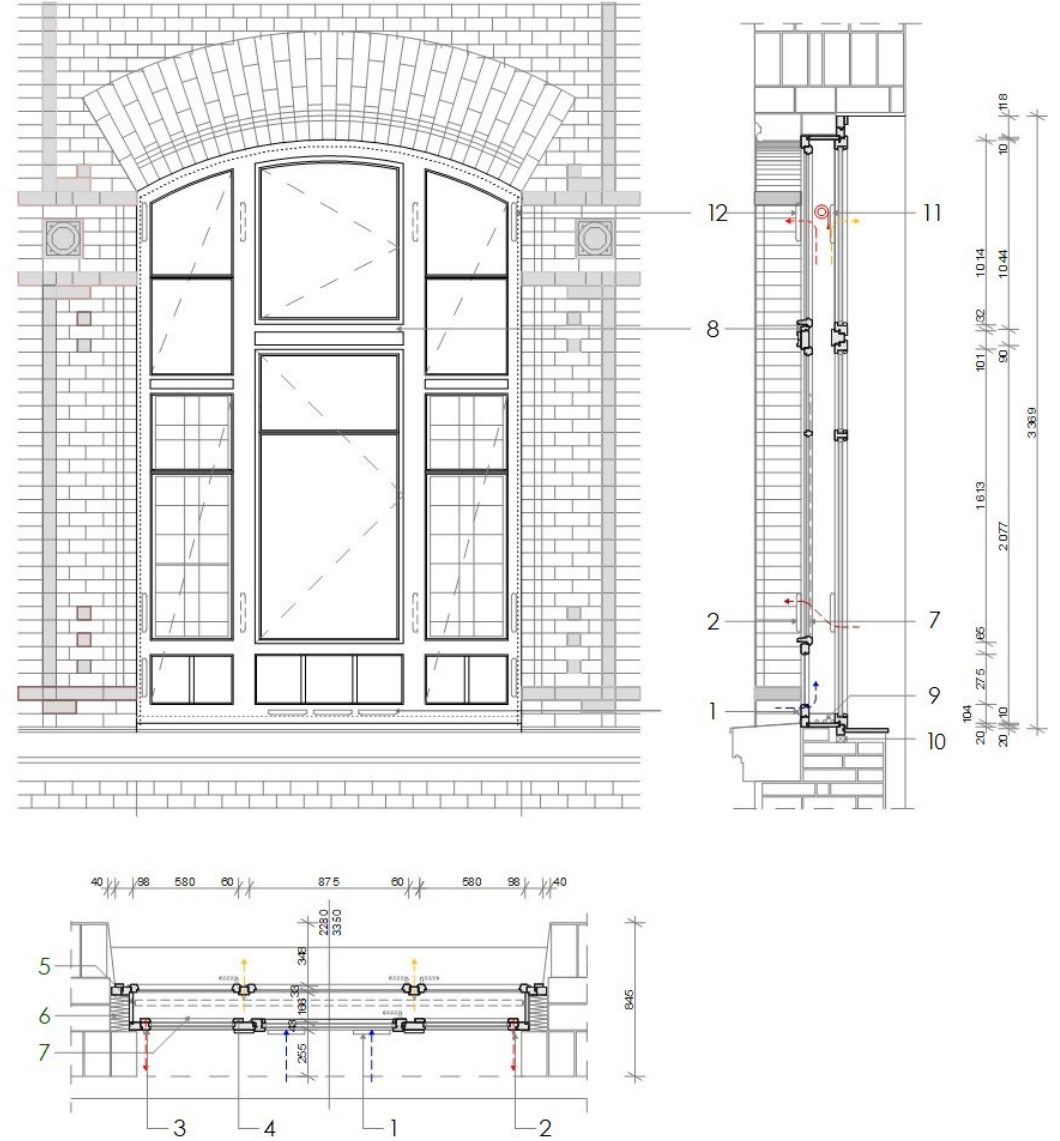
Figure 7. Combined window after reconstruction with ventilation operation. 1: inlet of fresh air with Aereco air inlet; 2: exhausting of used air; 3: 55/43 frame extension profile; 4: 55/23 frame covering glazing bead; 5: fixing of textile roller blind at the seats of the segmented arch; 6: mineral fiber sealing; 7: solar cell; 8: frame heightening 43/32; 9: cable duct; 10: seating profile 45/65; 11: inlet of warmed-up air in heating season open; 12: outlet of warm air in heating season closed.